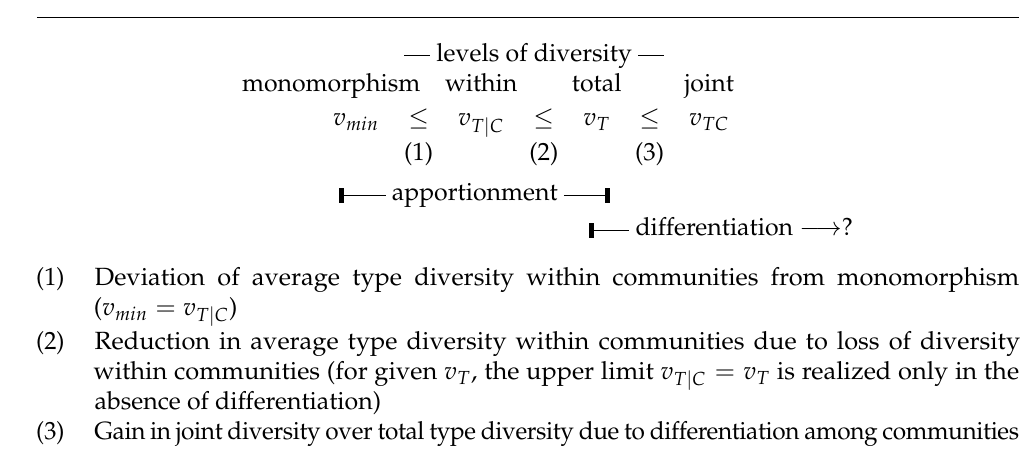
Table 2. Relations between the three levels of diversity (within communities, total, and joint), the ranges of diversity levels covered by apportionment and differentiation characteristics, and the effects on diversity associated with the transitions between diversity levels. (Modified after